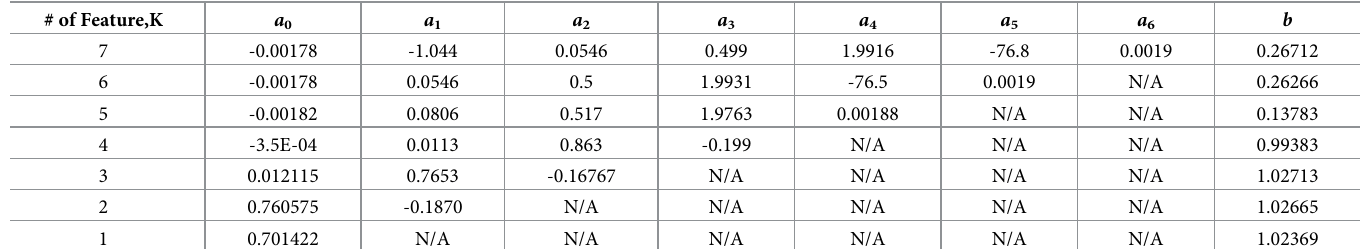
Table 4. Coefficient of linear regression based on feature selection.